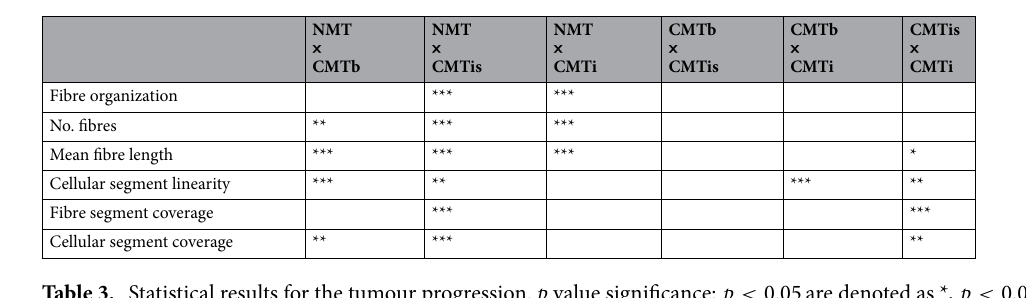
Table 3. Statistical results for the tumour progression. p value significance: p < 0.05 are denoted as *, p < 0.01 are denoted as ** and p < 0.001 are denoted as ***. Empty table cells denote not significant p NMT normal mammary gland, CMTb benign areas of carcinoma in mixed tumour, CMTis in situ areas of carcinoma in mixed tumour, CMTi invasive areas of carcinoma in mixed tumour. The p values were obtained by one-way ANOVA and Tukey’s HSD